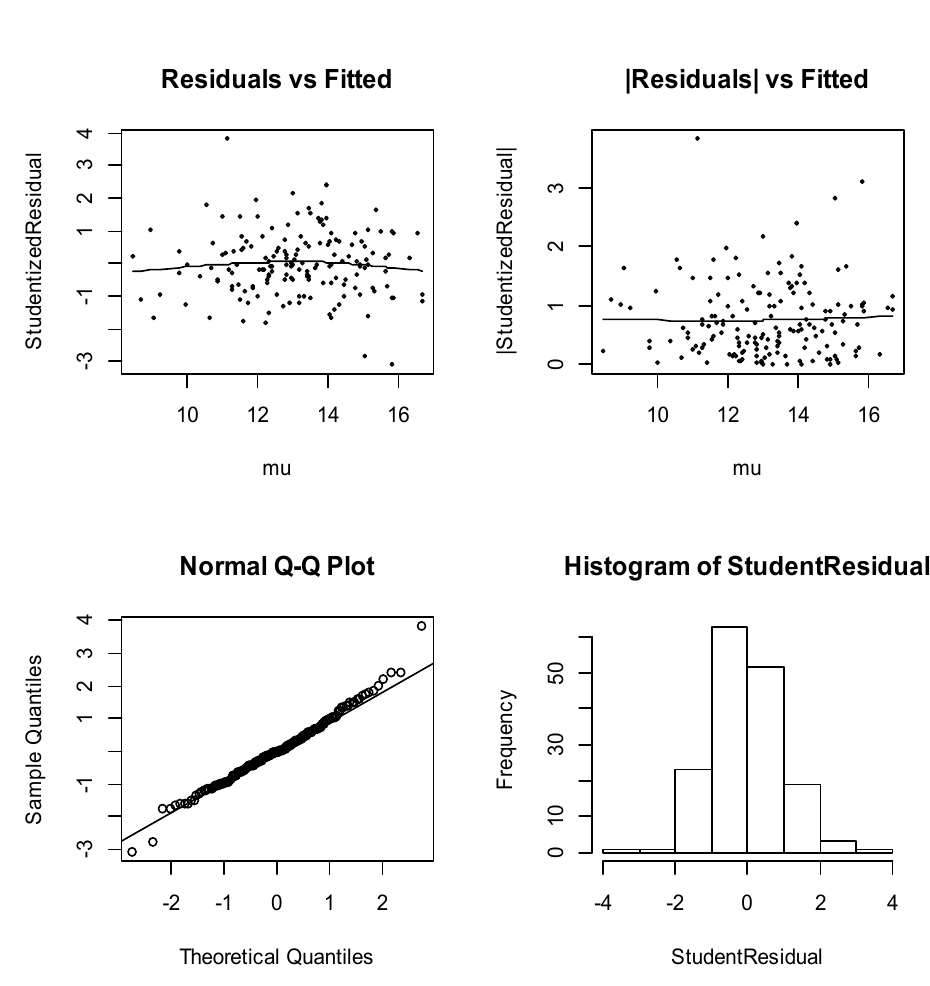
Figure 2. Diagnostic plots for Gaussian GLM.